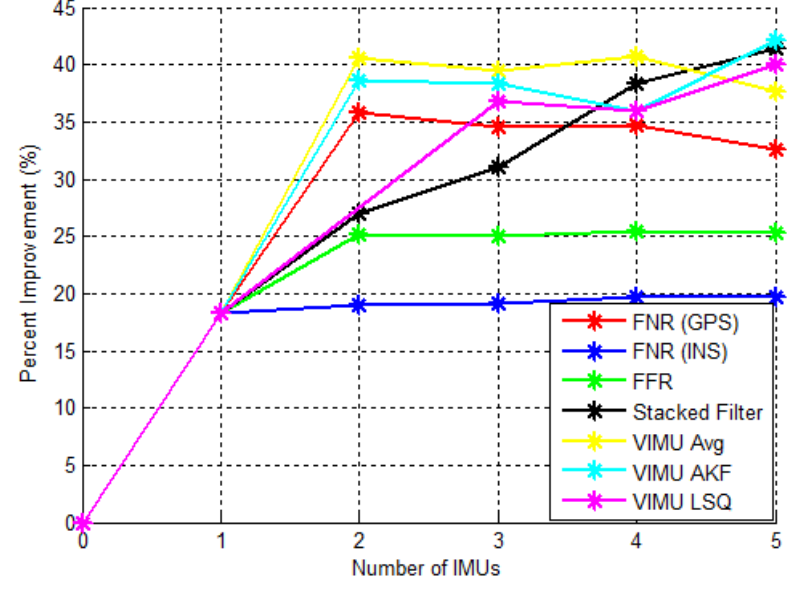
Figure 18. VIMU Accuracy Improvement as a Function of IMUs Used (Olympic Oval Data